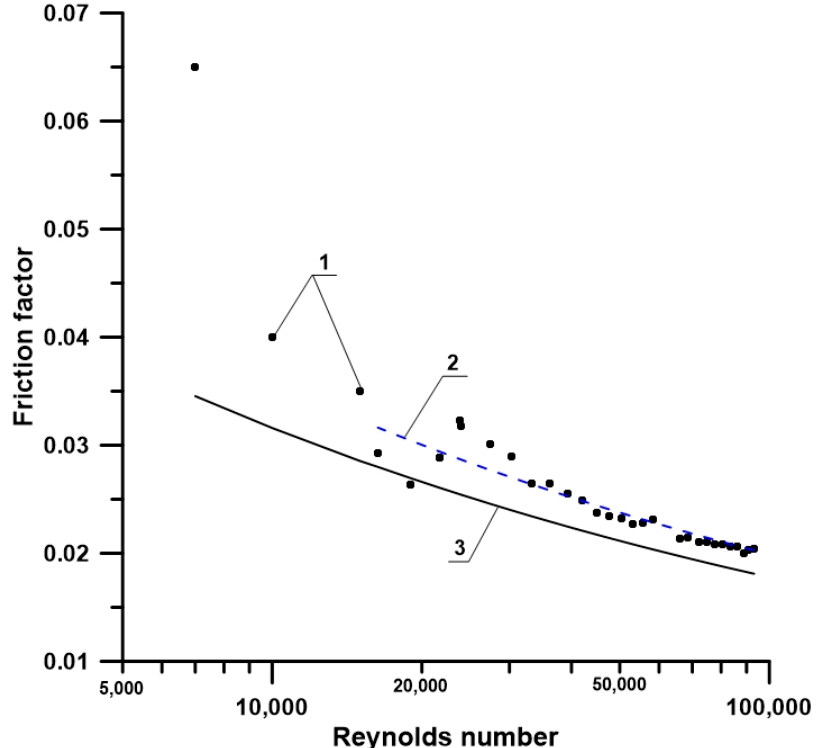
Figure 7. Friction factor values obtained experimentally and their comparison with smooth tubes; 1—experimental data; 2—the proposed equation (Equation (20)); 3—the Blasius equation (Equation (2)).